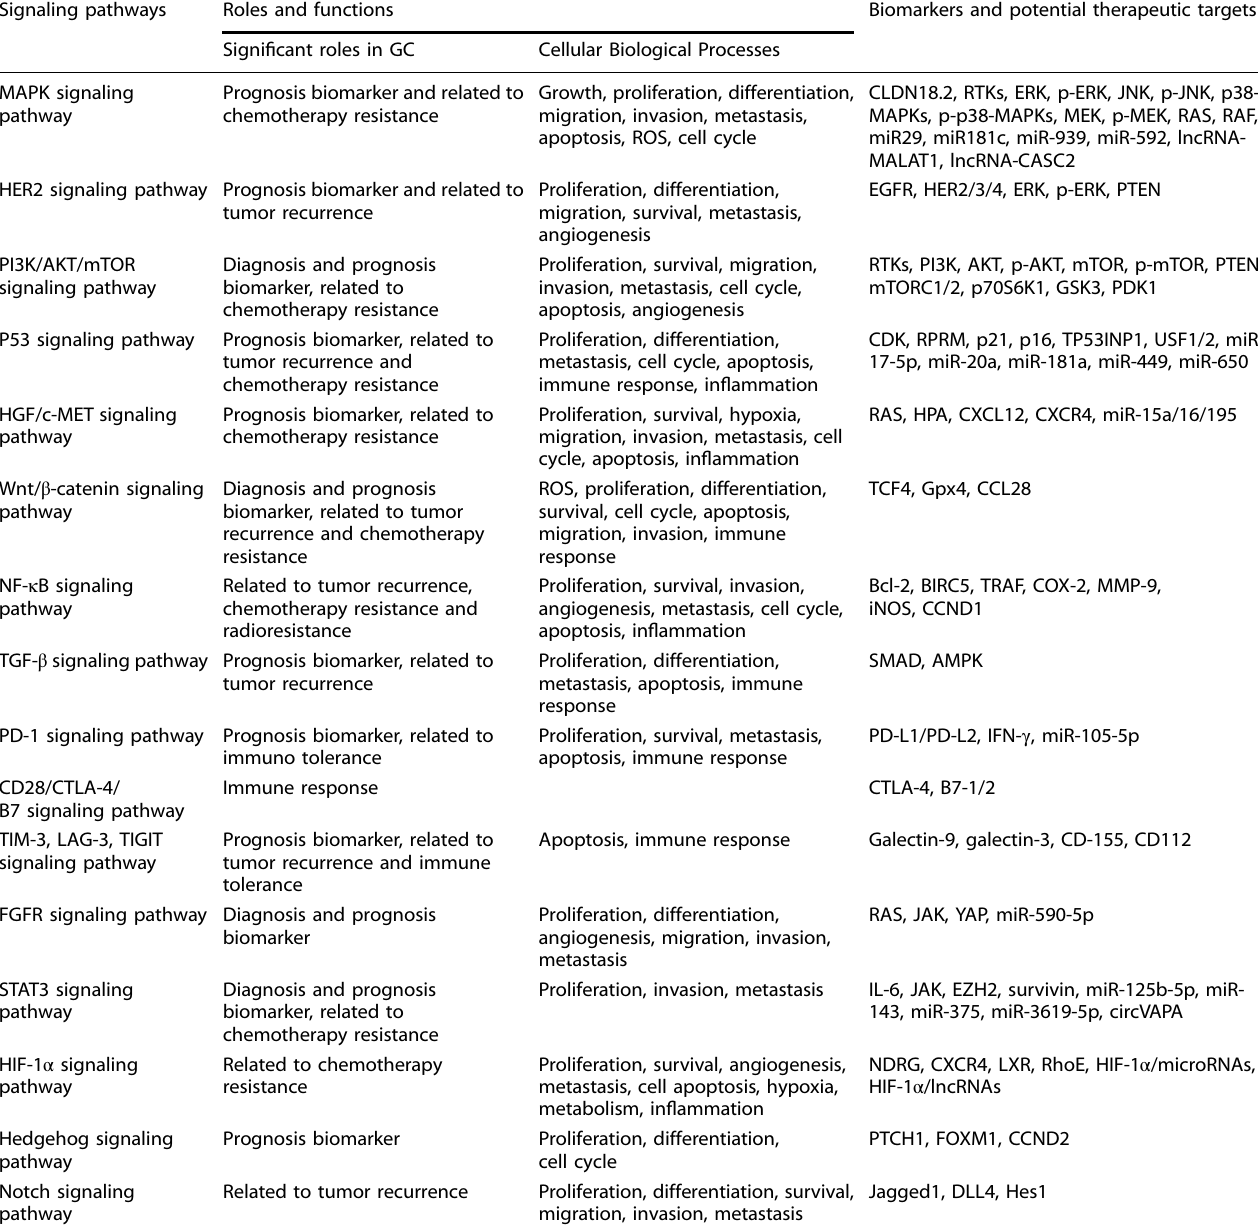
Table 2. The roles and functions of signaling pathways in gastric cancer, and the identi fi ed biomarkers as well as potential therapeutic targets Signaling pathways Roles and functions